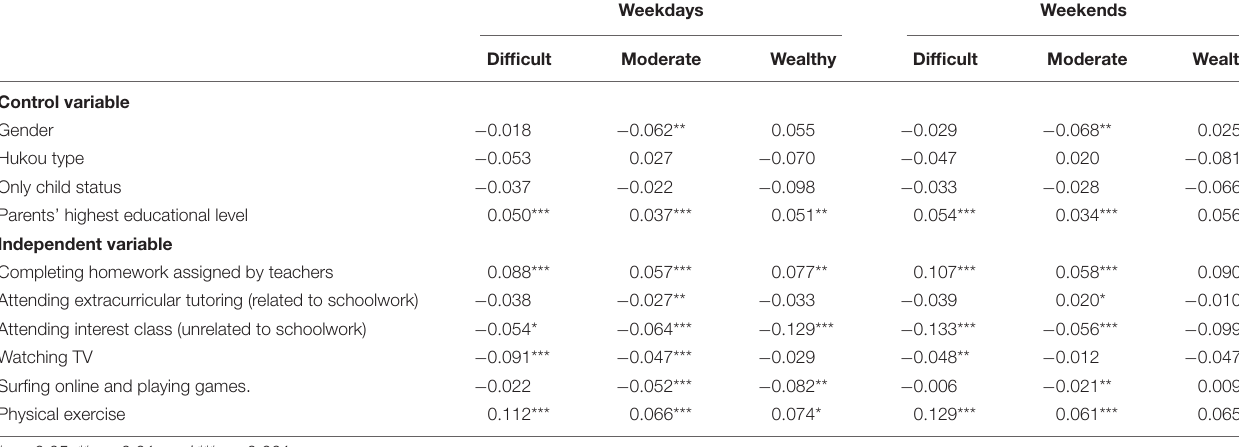
TABLE 6 | Fixed effects of extracurricular activities on cognitive ability in different family economic status groups.